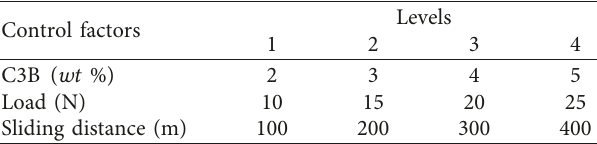
Figure 3: Rotating disc with Polyethylene/C3B/EAC nanocomposite. Table 2: Control factors and their